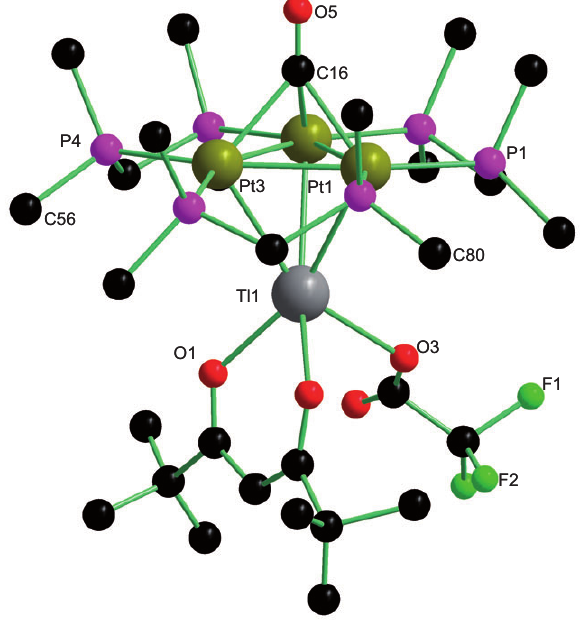
Figure 1 Structure of [( μ -dppm) Phenyl groups were omitted for clarity. Modified from Studnichenko et al. (2002).